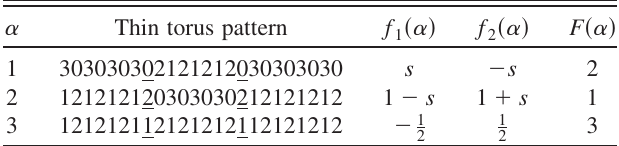
TABLE IV. c ¼ 0 thin torus patterns for a two-quasihole k ¼ 3 Read-Rezayi state, and the offset functions of the asso- ciated domain walls. The orbital positions 2 n Patterns for c ¼ 1 can be obtained by shifting each occupancy number one orbital to the right, and c ¼ 1 offset functions by adding or subtracting 1 to each offset function above, whichever is more